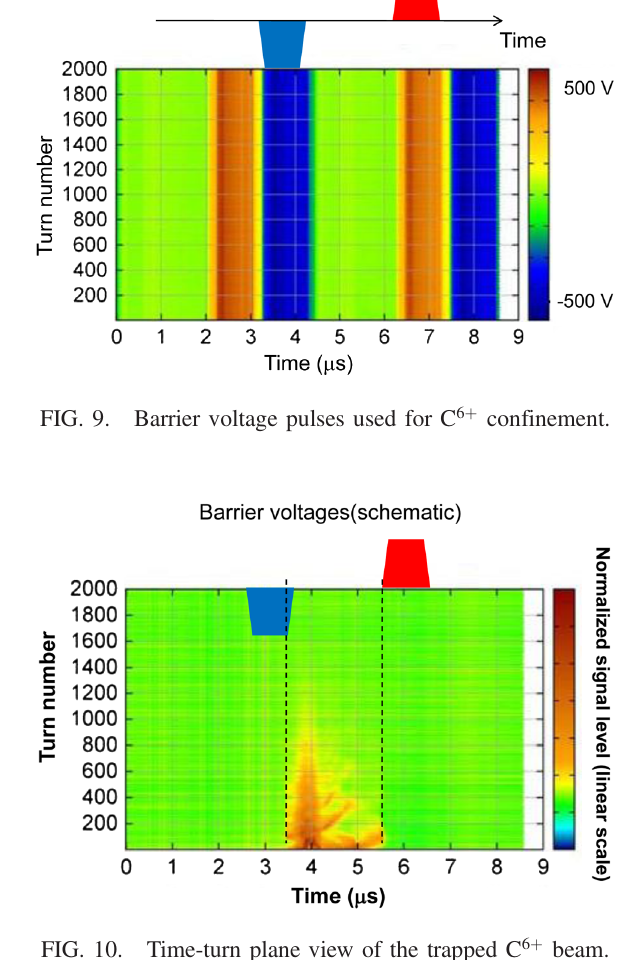
FIG. 10. Time-turn plane view of the trapped C 6 þ beam.